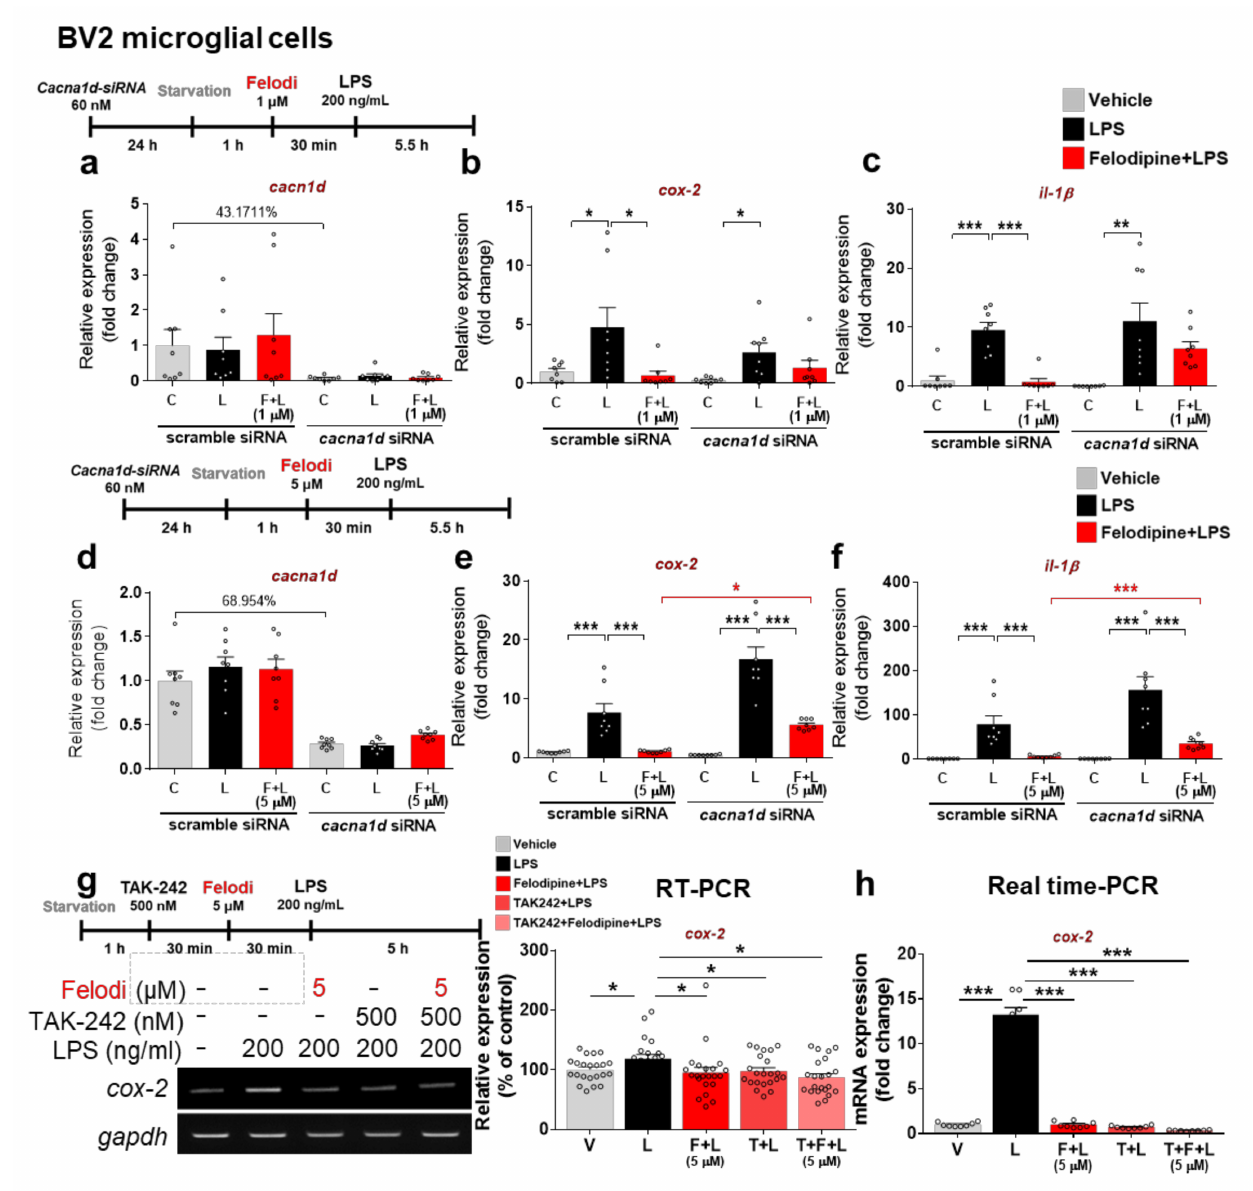
Figure 2. Felodipine downregulates LPS-stimulated proinflammatory responses through the L-type Ca 2+ channel and TLR4 signaling in BV2 microglial cells. ( a , d ) Real-time PCR analysis of cacna1d gene expression in cells treated with 1 µ M felodipine ( a ) or 5 µ M felodipine ( d ), followed by LPS as shown (n = 8/group). ( b , c , e , f ) Real-time PCR analysis of cox-2 and il-1 β mRNA levels in cells transfected with cacna1d siRNA (60 nM) or scramble (control) siRNA for 24 h and subsequently treated with 1 µ M felodipine ( b , c ) or 5 µ M felodipine ( e , f ) and with LPS as shown (n = 8/group). ( g , h ) RT-PCR and real-time PCR analyses of proinflammatory cytokine cox-2 expression in cells treated with TLR4 inhibitor (TAK-242), 5 µ M felodipine, and LPS (felodipine: n = 22/group). * p < 0.05, ** p < 0.01, *** p < 0.001. V: vehicle; L: LPS; F or Felodi: felodipine. 2.4. Felodipine Decreases LPS-Induced Proinflammatory Cytokine Levels by Decreasing AKT and STAT3 Phosphorylation in BV2 Microglial